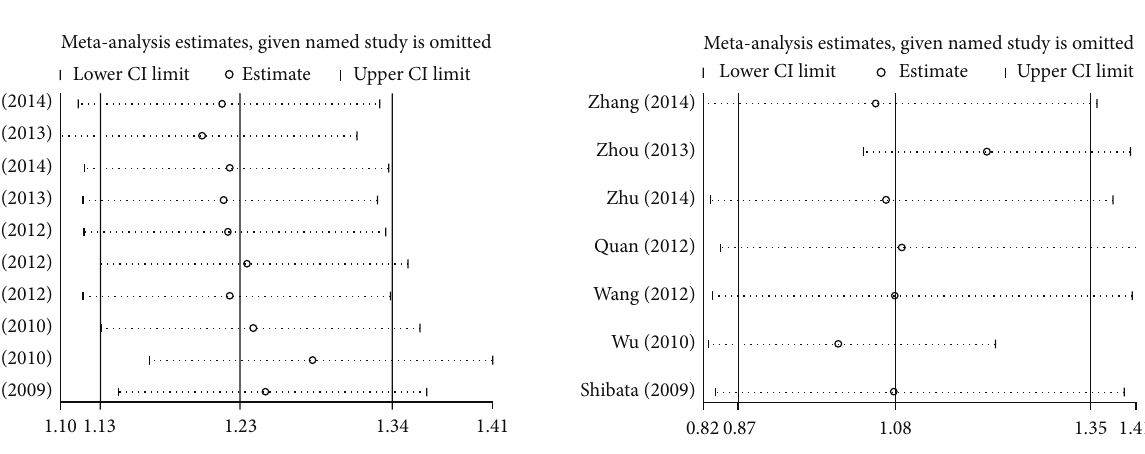
Figure 5: Sensitivity analysis through deleting each study to reflect the influence of the individual dataset on the pooled ORs in TC + CC versus TT model of IL-17F rs763780T > C